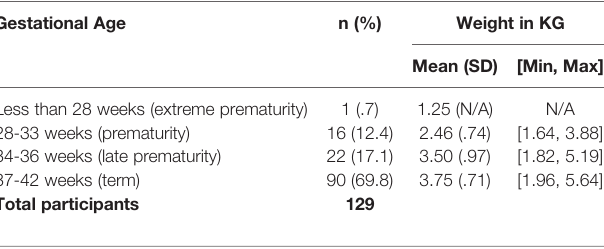
TABLE 3 | Birth weight and gestational age.